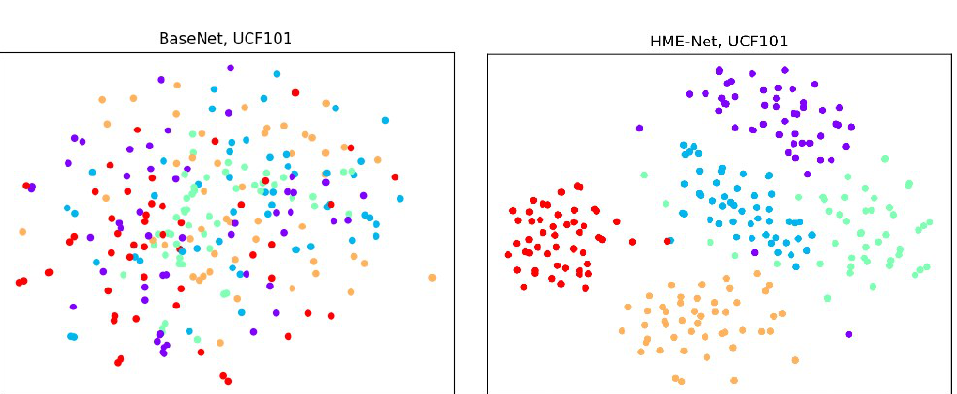
Figure 5. Visualization of few-shot classification using t-SNE [43]. Different colors represent different action classes. Five action classes are visualized in total. We compare our HME-Net with our baseline BaseNet on UCF101. The randomly selected categories include “PommelHorse”, “Surfing”, “CuttingInKitchen”, “Diving”, and “VolleyballSpiking” from the test